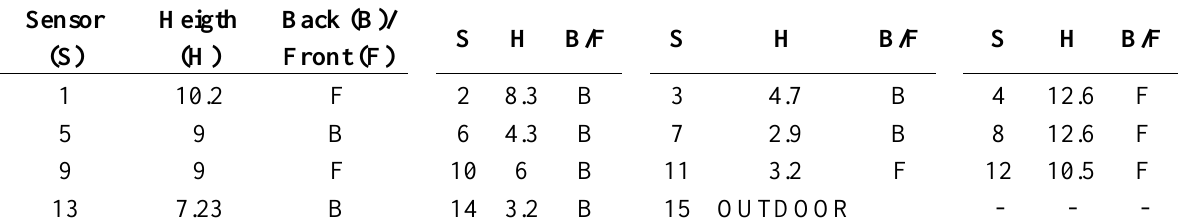
Table 1. Position in which the sensors were installed, specifying height (meters) and orientation (Back = B, Front =